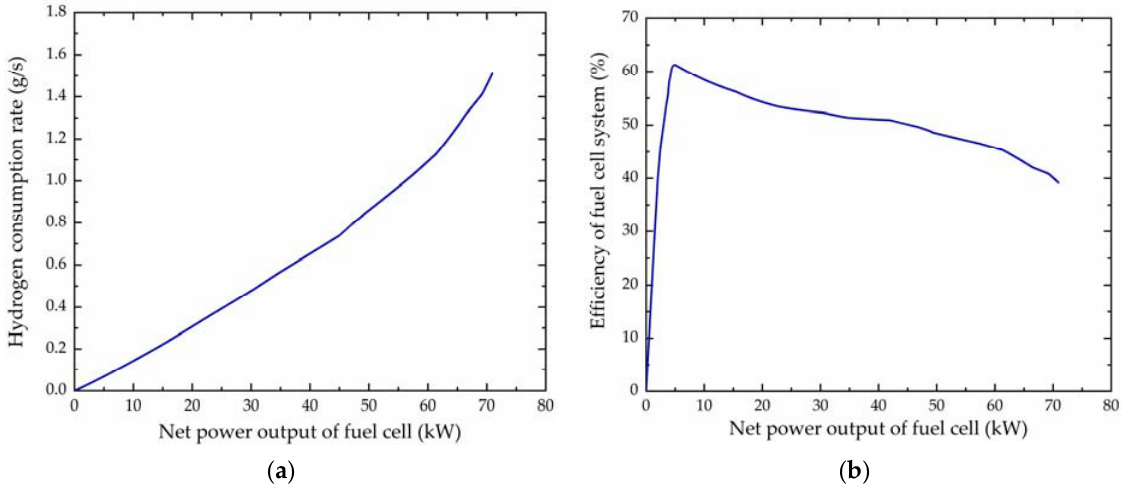
Figure 3. Characteristic curves of the fuel cell system. ( a ) Fuel cell hydrogen consumption rate and net output power curve; ( b ) Fuel cell system efficiency characteristic curve.